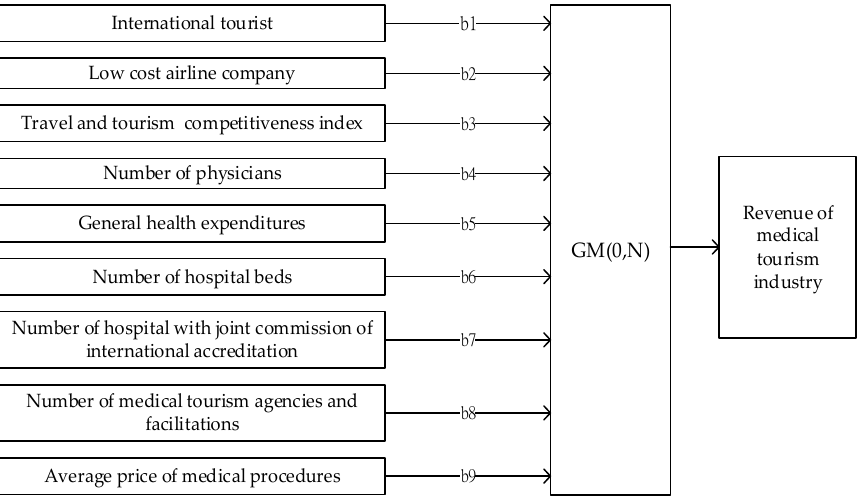
Figure 6. Analyzing framework of the Grey model (GM, 0,N) model.